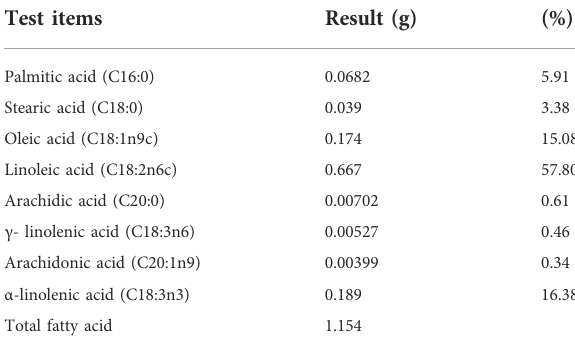
Supplementary Figure S1. Qualitative analysis of WECSL showed that most of the components were linoleic acid, linolenic acid, stearic acid, palmitic acid, and oleic acid. TABLE 2 Principal components of WECSL (fatty acid composition,